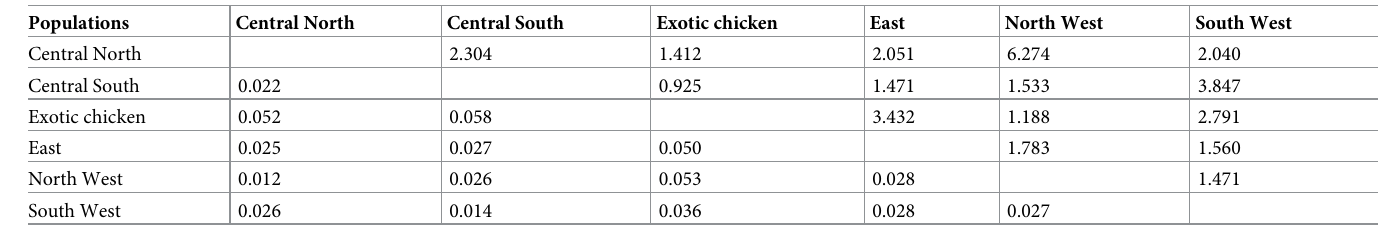
Table 7. Gene flow (upper diagonal) and Gene differentiation (lower